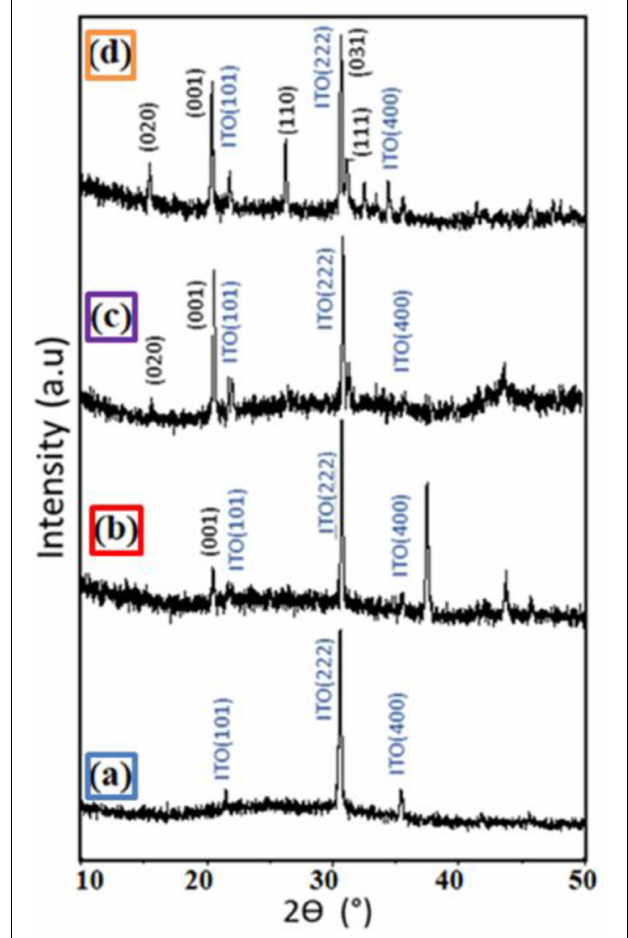
FIGURE 3 | XRD patterns of the (a) film of PEDOT:PSS (b) film hybrid 99 wt%–1 wt% PEDOT:PSS-V 2 O 5 (c) film hybrid 95 wt%–5 wt% PEDOT:PSS-V 2 O 5 and (d) film hybrid 90 wt%–10 wt% PEDOT:PSS-V 2 O 5 . All the films were deposited by bar coater (bar n = 3) at room